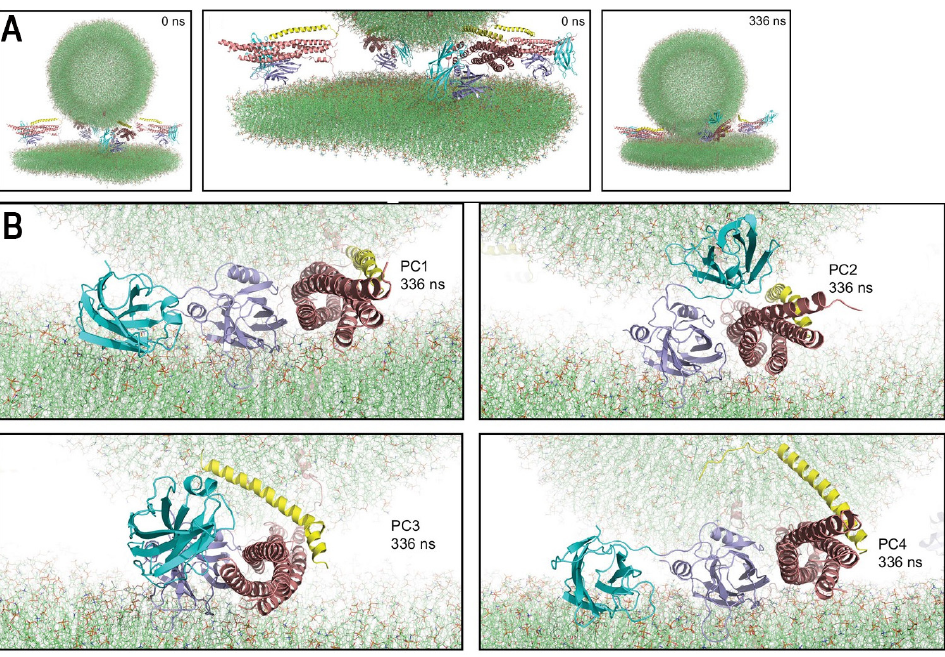
Figure 5. SV-PM fusion mediated by four Syt1-SNARE-Cpx complexes. ( A ) The system at the initial (0 ns) and final (336 ns) points of the trajectory. ( B ) Each of the four complexes between the bilayers of the SV and PM in the end of the trajectory. Note that all the complexes have the C2B domains (navy) attached to the SNARE bundles. In contrast, the positions of the C2A domains (cyan) vary: two complexes (PC1 and PC4) have the C2A domain attached to the the PM, while the other two complexes (PC2 and PC3) have the C2A domains interacting with Cpx (yellow) and bridging to the SV. Reproduced from [92].